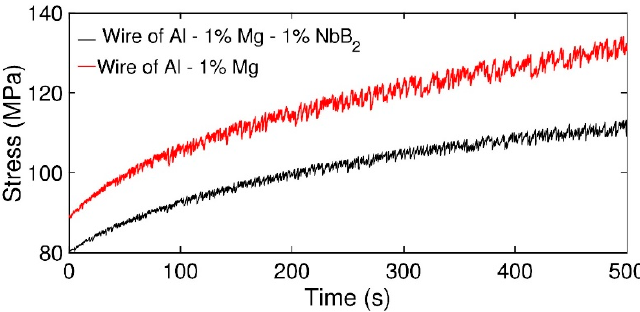
Figure 4. Tensile curve (tension versus time) displaying the PLC phenomenon.